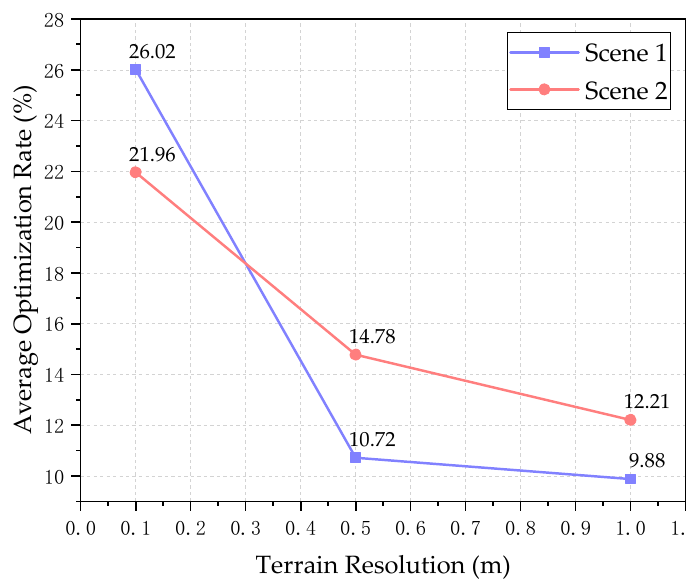
Figure 18. Average optimization rate with different terrain resolution. The label under each point is the average optimization rate at that resolution.